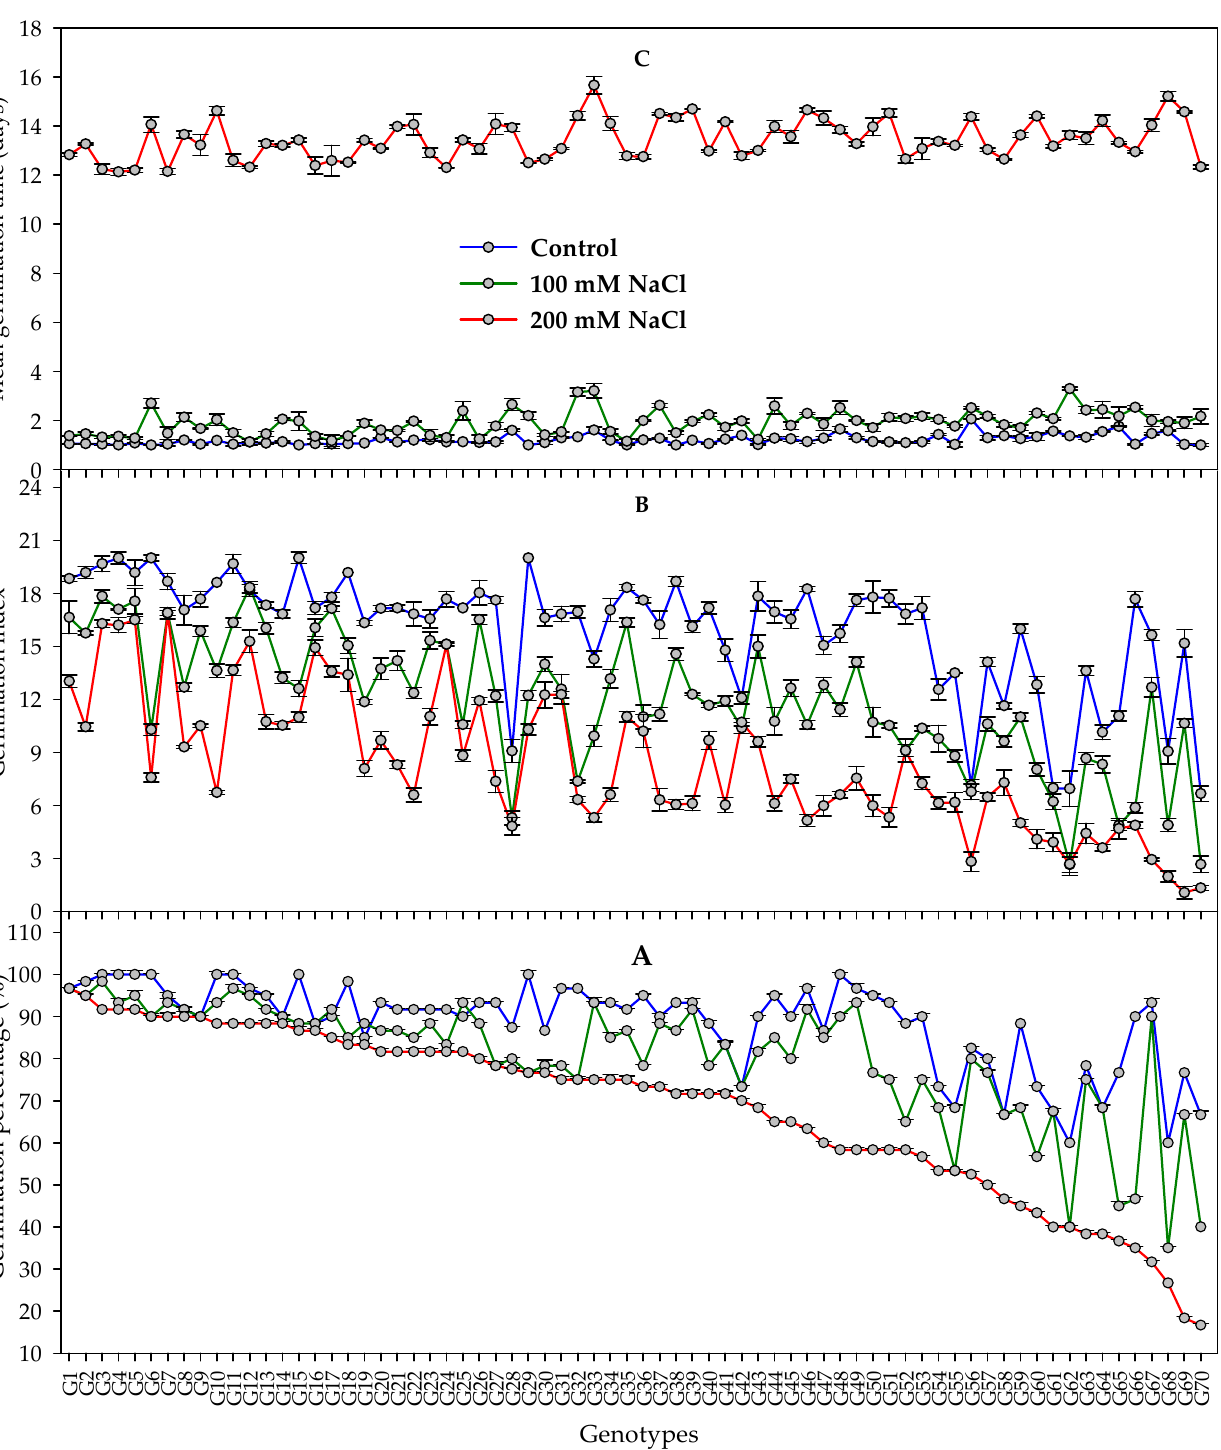
Figure 1. Effects of different salt concentrations on germination percentage ( A ), germination index ( B ), and mean germination time ( C ) of 70 barley genotypes under control, 100 mM NaCl, and 200 mM NaCl. Data are means ± SE (n = 3). The full names of the different abbreviations of genotypes are listed in Table 1.